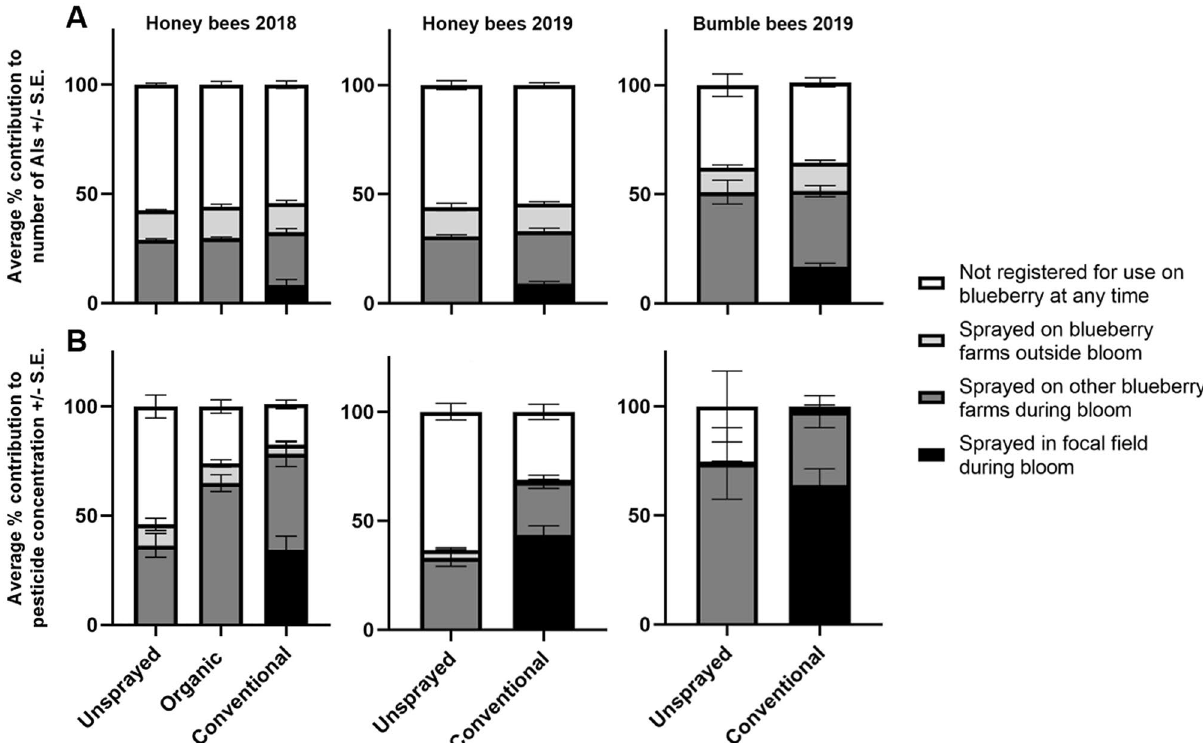
Figure 3. Average percent contribution of pesticides to the ( A ) number of active ingredients (AIs) detected at a site, and ( B ) overall sample concentration. Contributions were determined by spray records and registration status. Active ingredients are separated into those that were either applied on the focal field during bloom (black), registered for use on blueberries during bloom but not sprayed in the focal fields (dark grey), registered for use on blueberries outside bloom (light grey) or not registered for use on blueberries at any time (white). Graph created in GraphPad Prism 9 31 For honey bees at conventional farms, the contribution of AIs to the sample concentration was split between AIs that were sprayed on the focal farm, those that were likely sprayed on neighboring conventional farms, and AIs that are not registered for use on blueberry. Much lower contribution came from AIs used on blueberry farms post-bloom. In contrast, for bumble bees the majority of the pesticide concentration in samples came from AIs sprayed on the focal farm, with the rest primarily being AIs sprayed on neighboring blueberry farms during bloom. Much less contribution came from AIs not registered for use on blueberry or those sprayed on blueberry post-bloom (Fig. 3B). For pollen collected by honey bees in 2018 and bumble bees in 2019, the majority of high detections came from AIs that were either sprayed on the focal farm during bloom or likely from neighboring blueberry farm management during bloom (Table 1). However, for honey bees in 2019, the highest detections came from an AI not registered for use in blueberry pest management at any time of the year. Carbendazim was the highest detection at both conventional (5753.6 ppb) and unsprayed (2333.2 ppb) farms in 2019 (Table 1). Carbendazim and thiophanate-methyl, of which carbendazim is a metabolite, are AIs of fungicides not registered for use in blueberries so it is assumed these residues came from farms growing other crops. Conversely, for bumble bees at the same farms, the highest detections (top 20 highest detection concentrations for bumble bees) were all AIs of products registered for use in blueberries during bloom, including the fungicide boscalid (highest: 1757.6 ppb) and the insecticide methoxyfenozide (1406.2 ppb) (Table 1). Blueberry pollen collection. On average, pollen trapped from honey bee colonies in 2019 had 1.8% ± 3.2 blueberry pollen, while pollen collected from bumble bees had 25.9% ± 3.2 blueberry pollen. Blueberry pollen was collected from honey bee pollen traps at eight out of the 14 farms in 2019. At these eight farms, blueberry pollen made up between 0.04 and 16.7% of the total pollen collected. Pollen collected by bumble bees included blueberry pollen in all 15 farms in 2019, ranging from 3.9% of total pollen gathered to 45.6%. Although the amount of blueberry pollen explained only 6% of the variation in concentration of pesticides used during blueberry bloom, there was a positive correlation between pesticide concentration and the amount of blueberry pollen collected from honey bee pollen traps (R 2 = 0.06; F 1,95 = 5.54, p = 0.02). This relationship was not significant for bumble bees (R 2 = 0.11; F 1,14 = 1.53, p = 0.24).